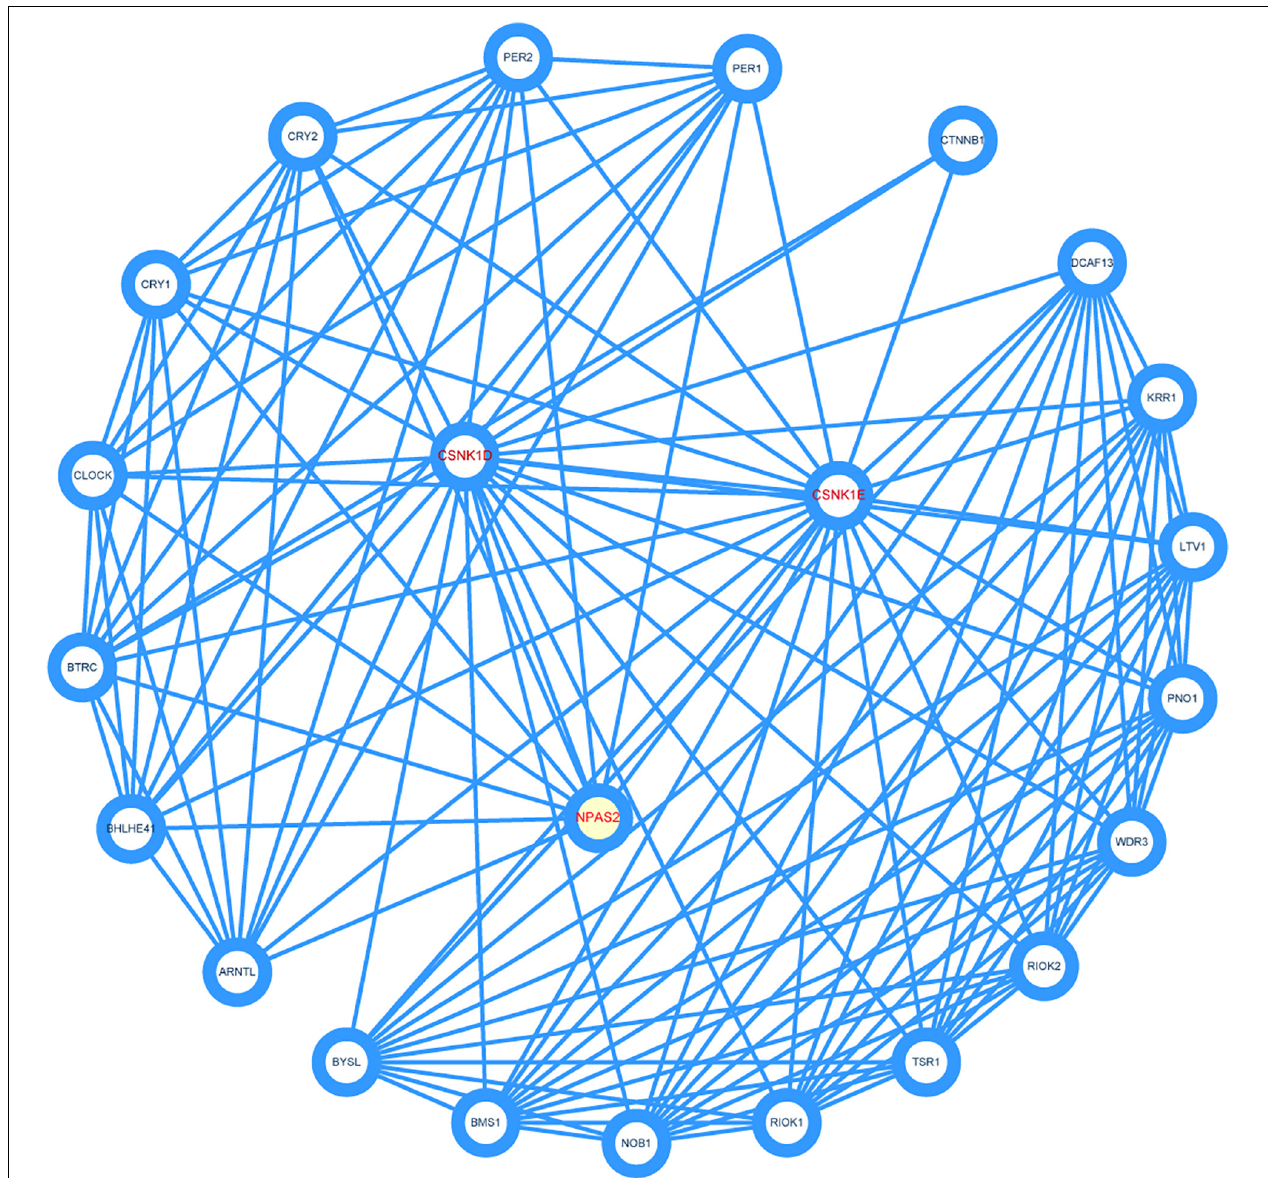
FIGURE 7 | Construction of protein-protein interaction (PPI) network. Three hub genes were marked